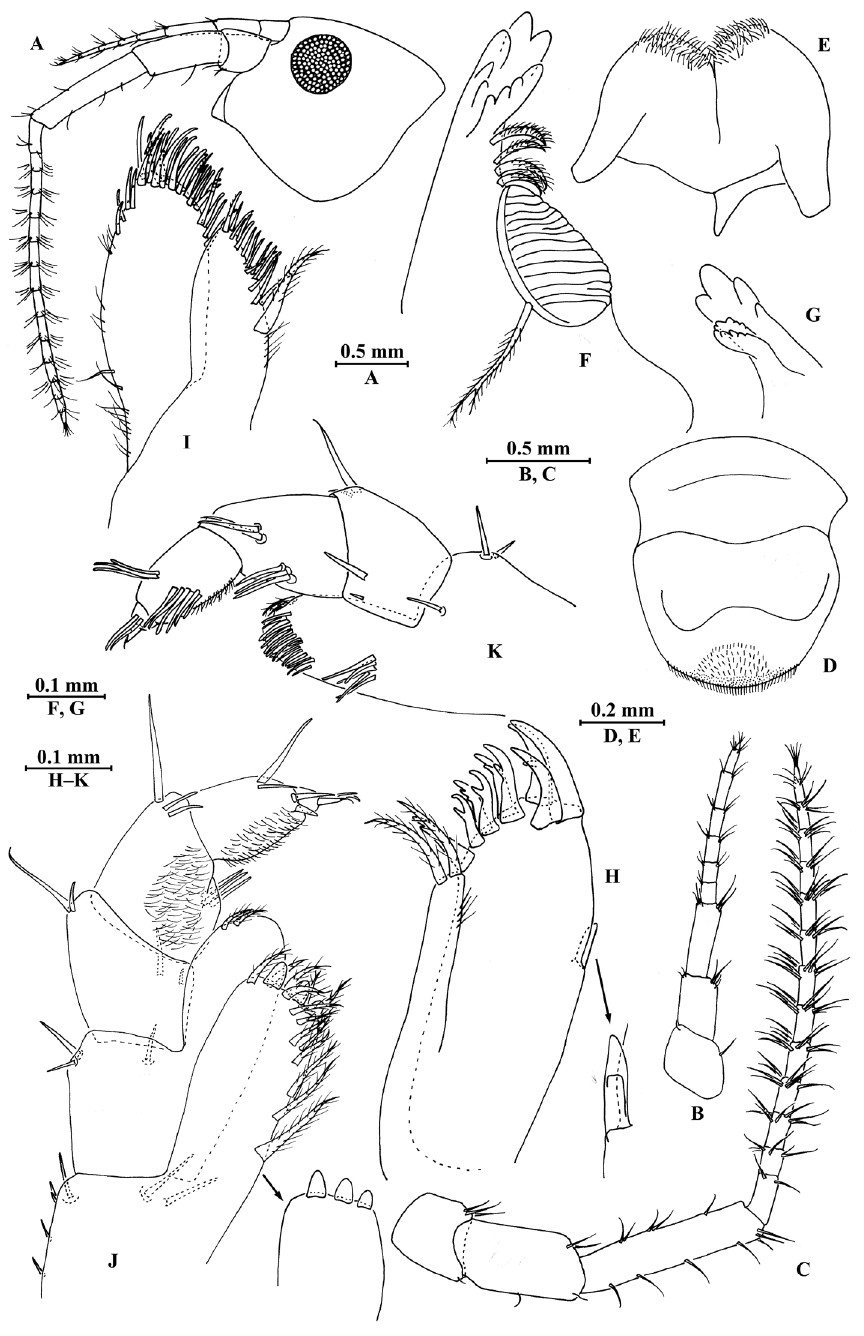
Figure 7. Myanmarorchestia seabri Hou, sp. n., male holotype. A head B antenna I C antenna II D up- per lip E lower lip F left mandible G incisor of right mandible H left maxilla I I maxilla II J maxilliped K outer plate and palp of left